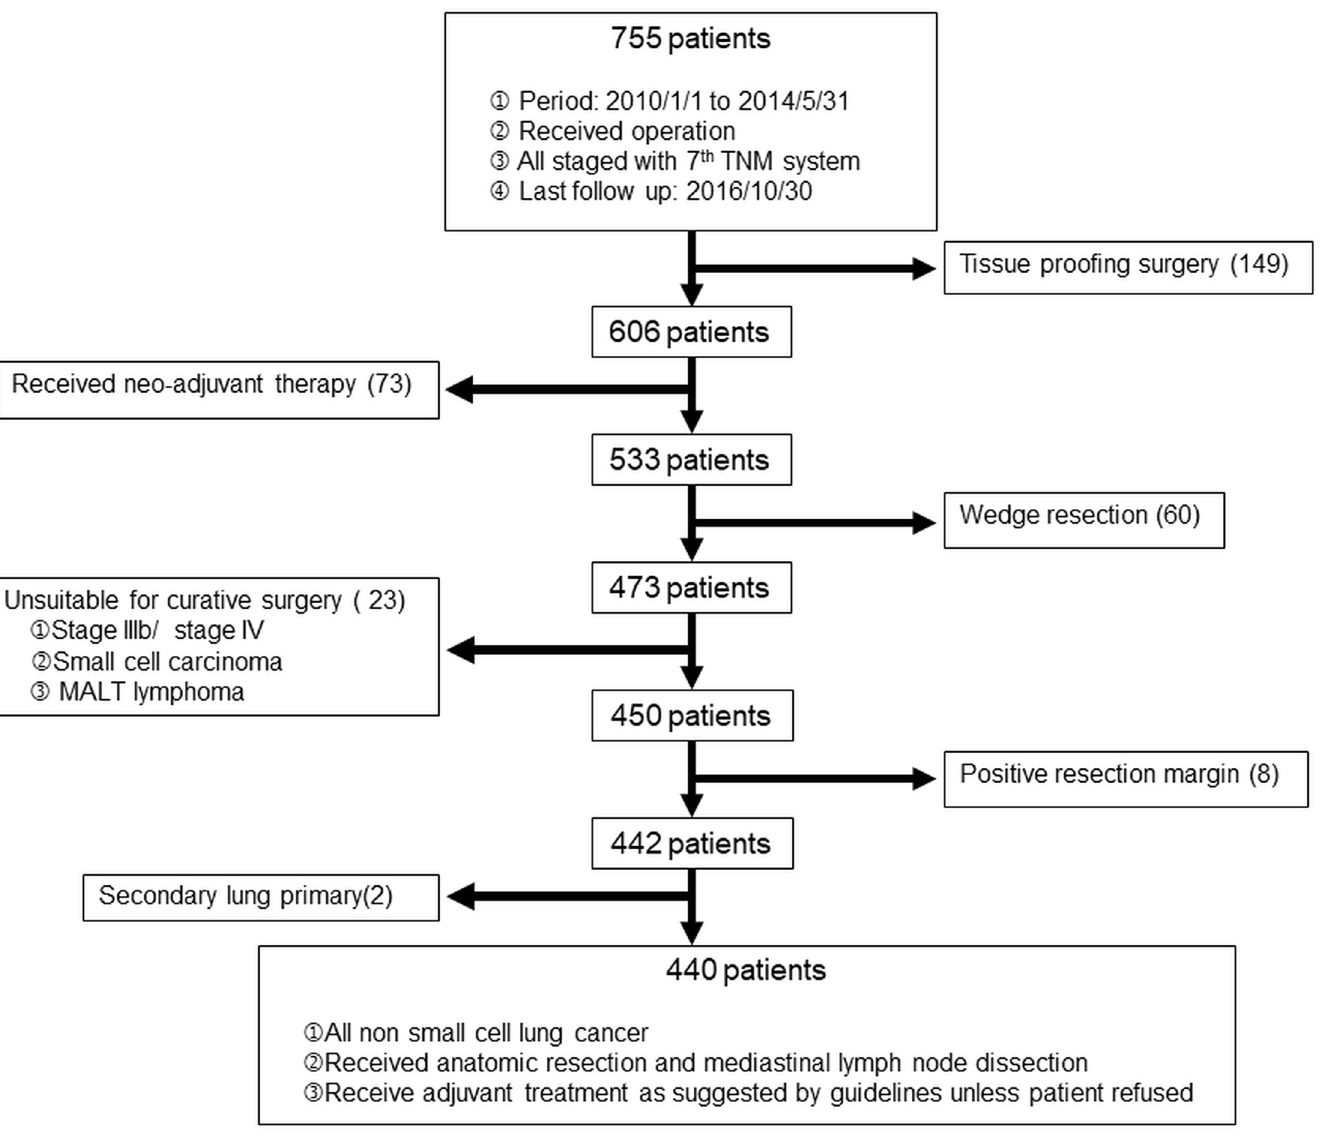
Fig 1. Exclusion